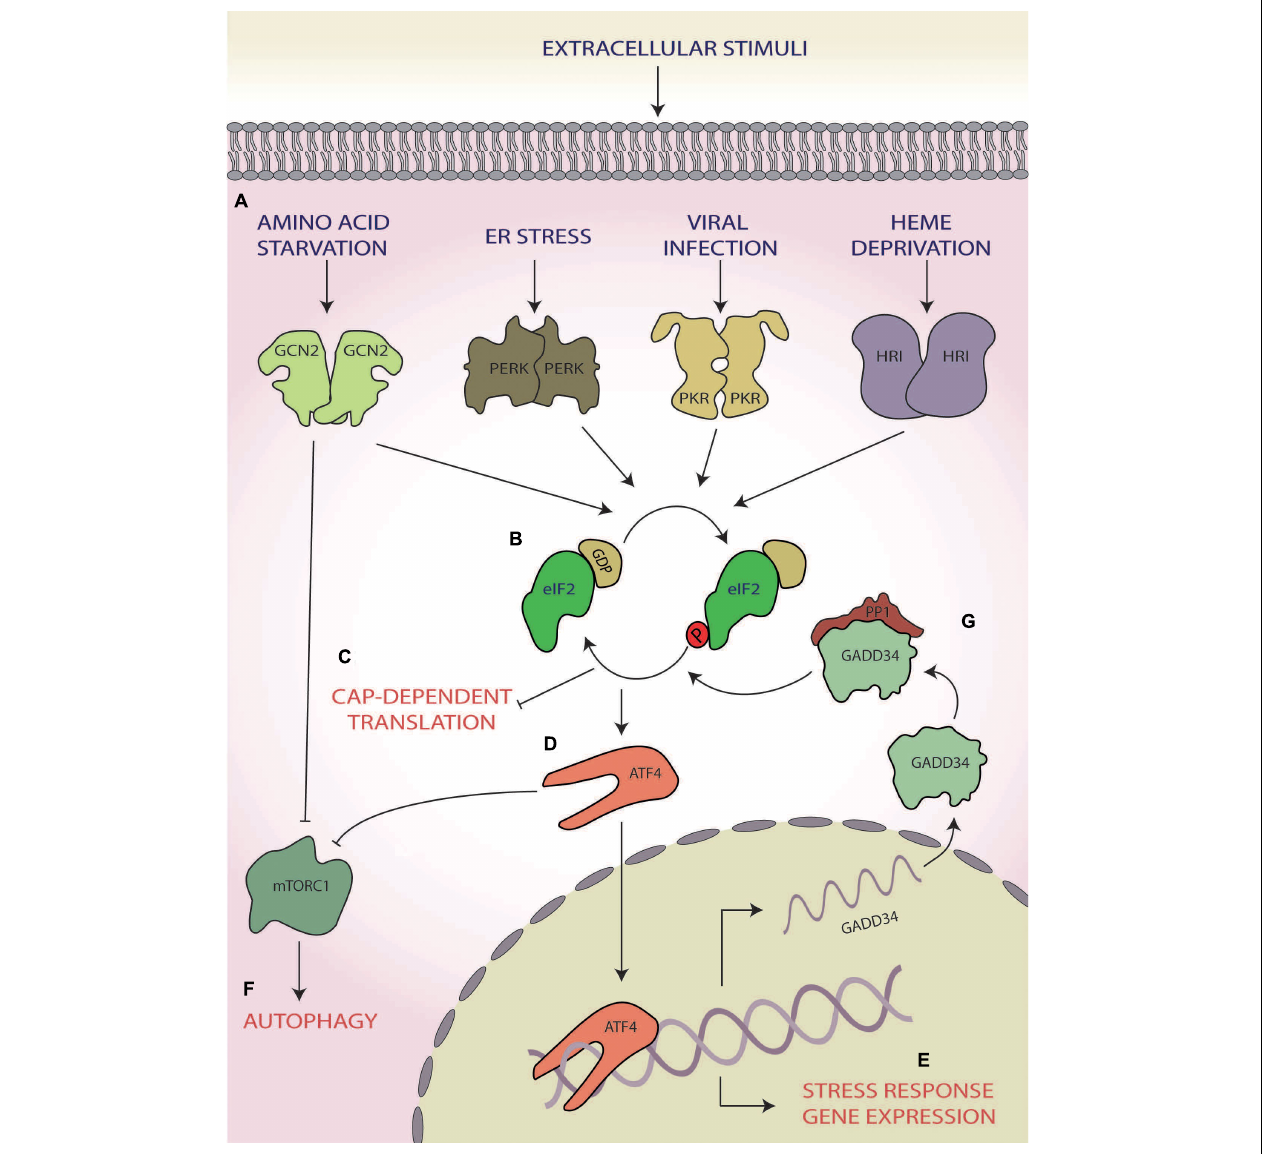
FIGURE 1 | The integrated stress response (ISR). (A) A range of cellular stress stimuli activate one of four stress response kinases, general control non-depressible 2 (GCN2), protein kinase R-like endoplasmic reticulum (ER) kinase (PERK), protein kinase R (PKR), and heme-regulated inhibitor HRI kinases, which (B) phosphorylate eukaryotic initiation factor 2 alpha (eIF2 α ). (C) This results in abrogation of canonical translation initiation, (D) which selectively upregulates the translation of ISR effector mRNAs, such as activating transcription factor 4 (ATF4). (E) These effectors bind to and target genes involved in cellular reprogramming for expression. (F) GCN2 and ATF4 also both induce autophagy via inhibition of mammalian target of rapamycin complex 1 (mTORC1). (G) If stress is overcome, the stress-inducible phosphatase growth arrest and DNA damage-inducible protein (GADD34) dephosphorylates eIF2 α , returning homeostatic translation initiation and terminating the